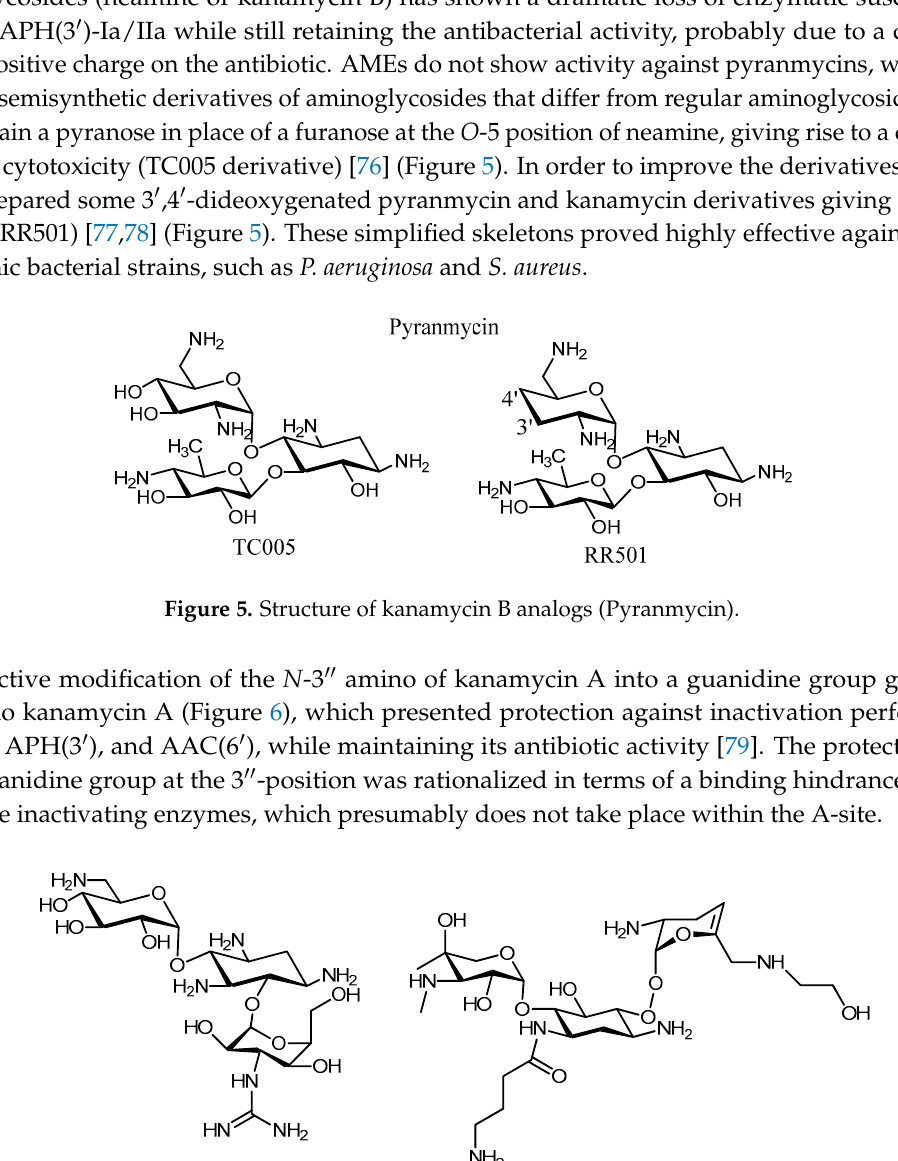
Figure 6. Structure of the N -3’’-Guanidino Kanamycin A and Plazomicin.